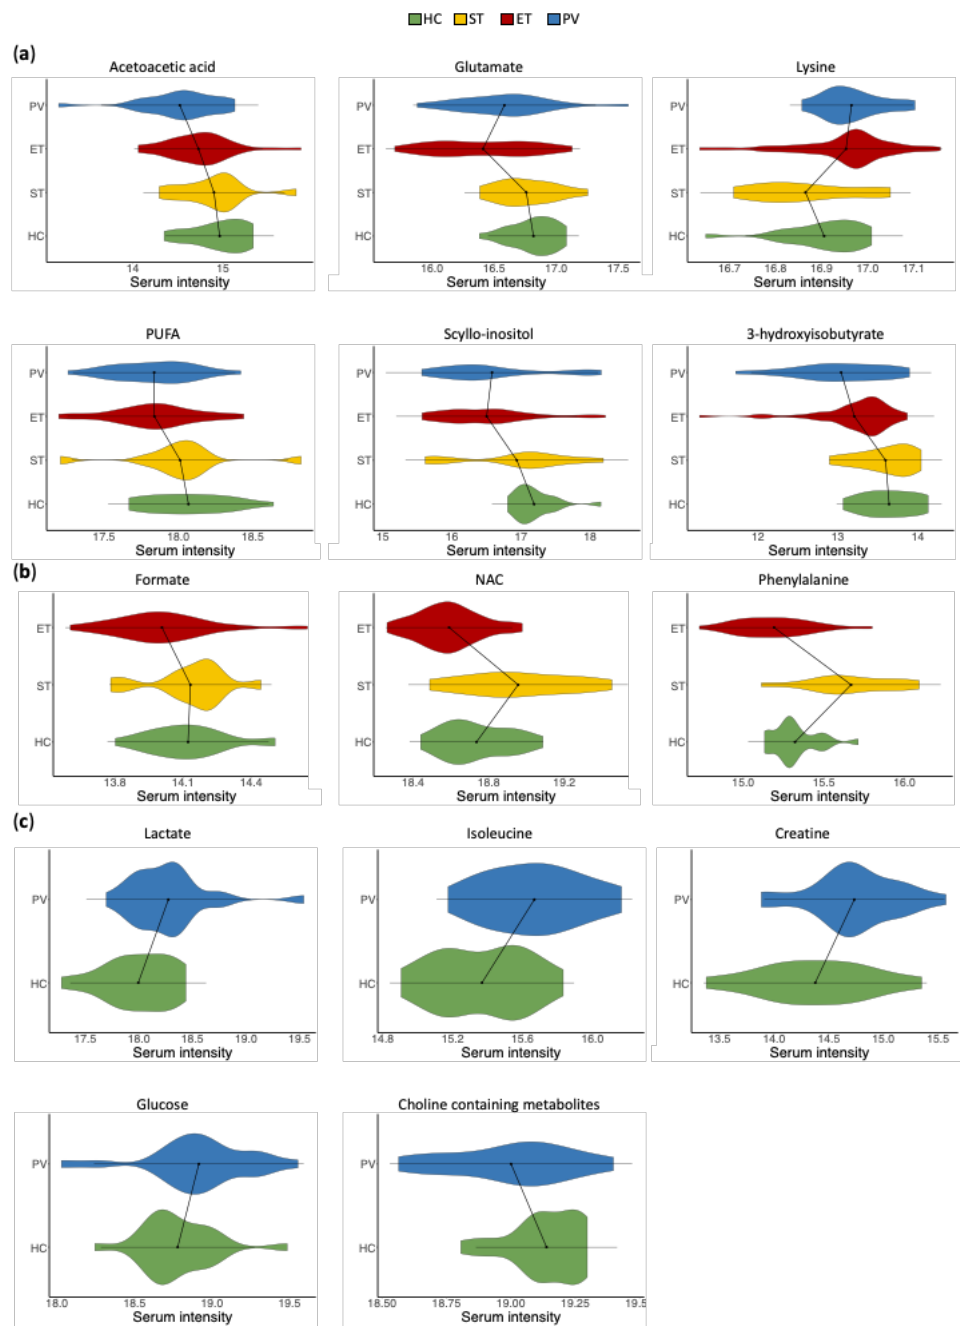
Figure 3. Violin plots representing the serum intensities (logarithmic scale) of statistically significant metabolic changes. Statistically significant alterations between the groups of study were observed in ( a ) metabolites that showed changes in both PV and ET patients, when compared with HC; ( b ) metabolites that were altered in ET (but not in PV) patients when compared with HC and ST; and ( c ) metabolites that were altered in PV (but not in ET) patients when compared with HC. HC: